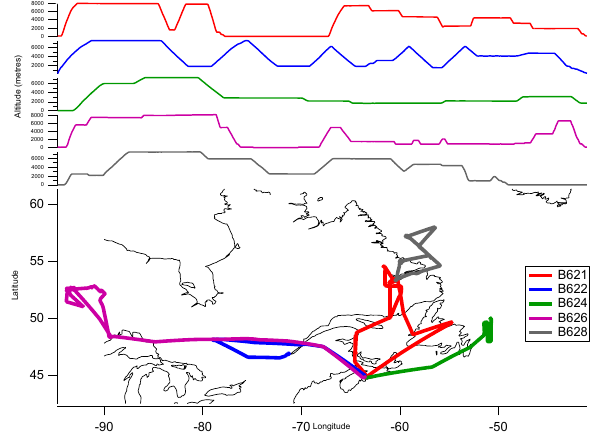
Fig. 3. The flight tracks from BORTAS-B from the CIMS data are presented